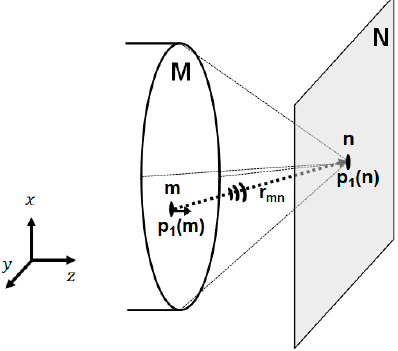
Figure 1. Basic concept of the distributed point source method.